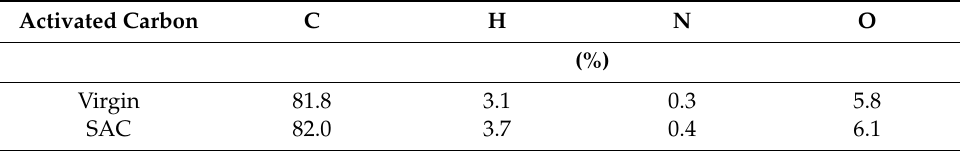
Table A1. Elemental analysis of virgin carbon and SAC.